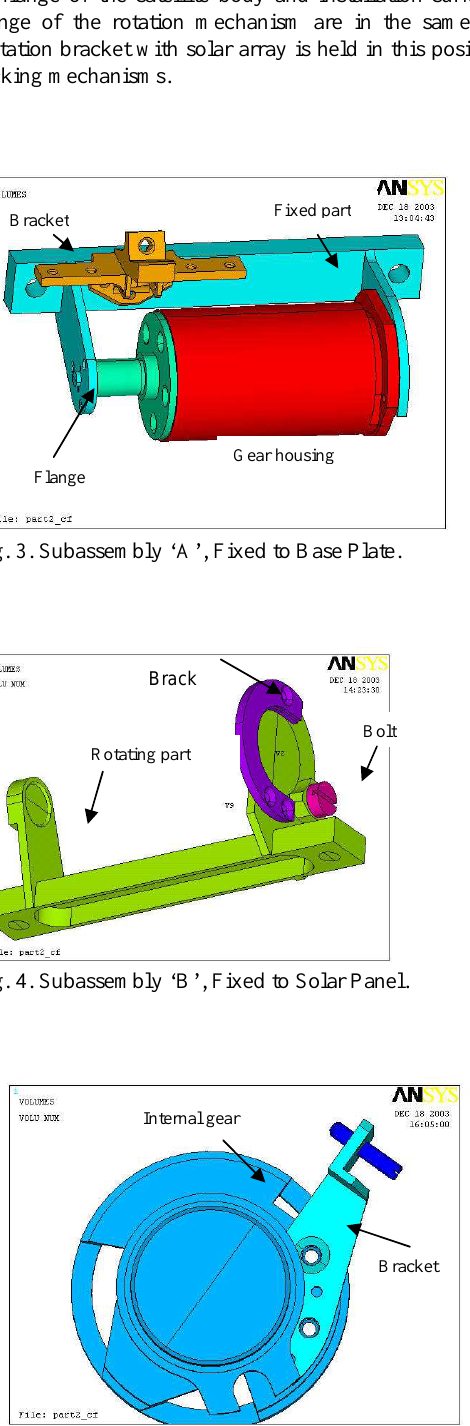
Fig. 5. Subassembly